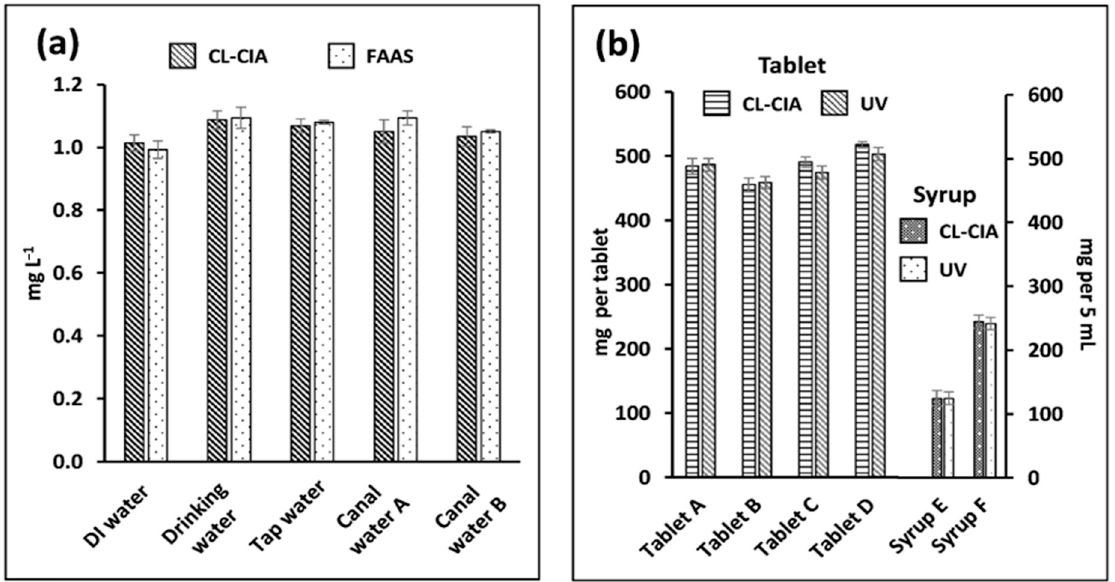
Figure 3. Results of the CL-CIA methods for the quantification of ( a ) Co(II) spiked in water samples and ( b ) paracetamol (tablets and syrups). The results are compared with the reference methods, i.e., FAAS for Co(II) and UV absorbance at 243 nm for paracetamol.